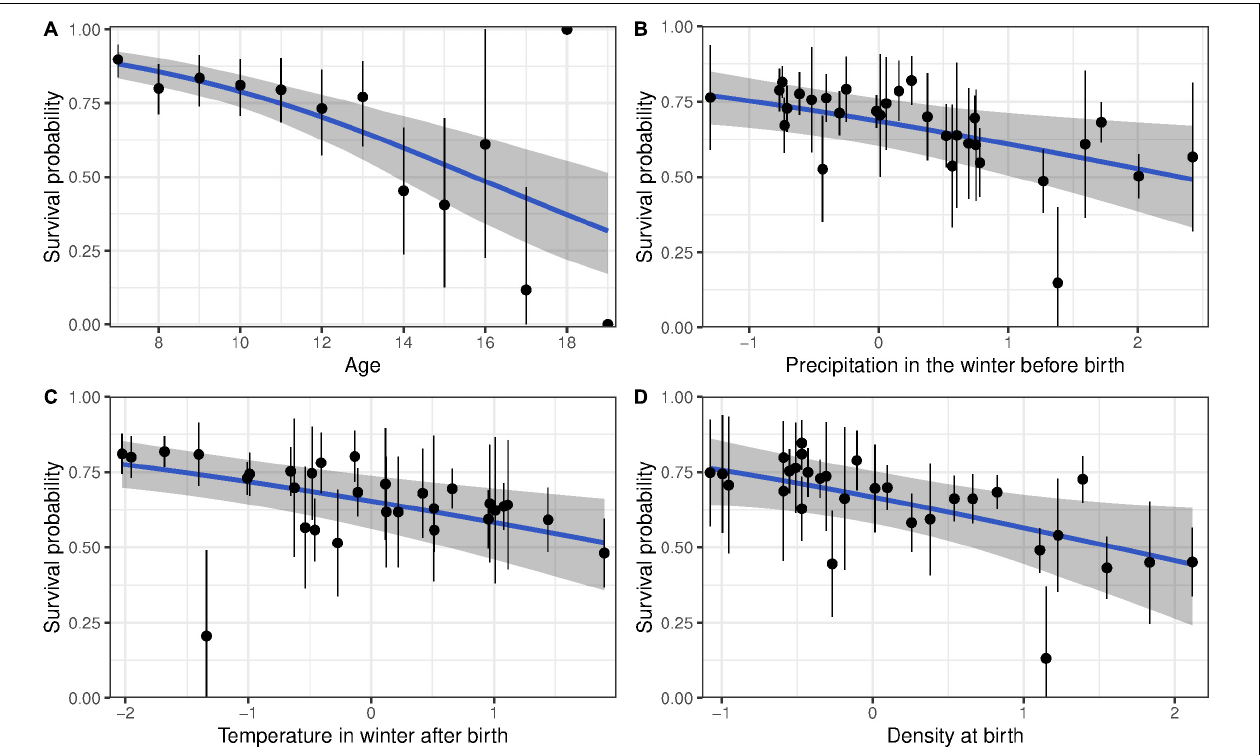
FIGURE 1 | Survival probability of bighorn sheep females born at Ram Mountain, Canada, 1973–2004. (A) Shows the age-related decline in survival for females aged 7 years and older, adjusted for current and birth environmental conditions. (B–D) show survival of females adjusted to age 13 according to (B) precipitation in the winter before birth, (C) temperature in the first winter of life, (D) population density at birth. The blue line shows predicted survival with associated 95% CI given a linear decline in survival with age. The points in panel (A) show average ( ± 95% CI) age-specific survival while points in panels (B–D) show each cohort’s survival ( ± se) adjusted to age 13.